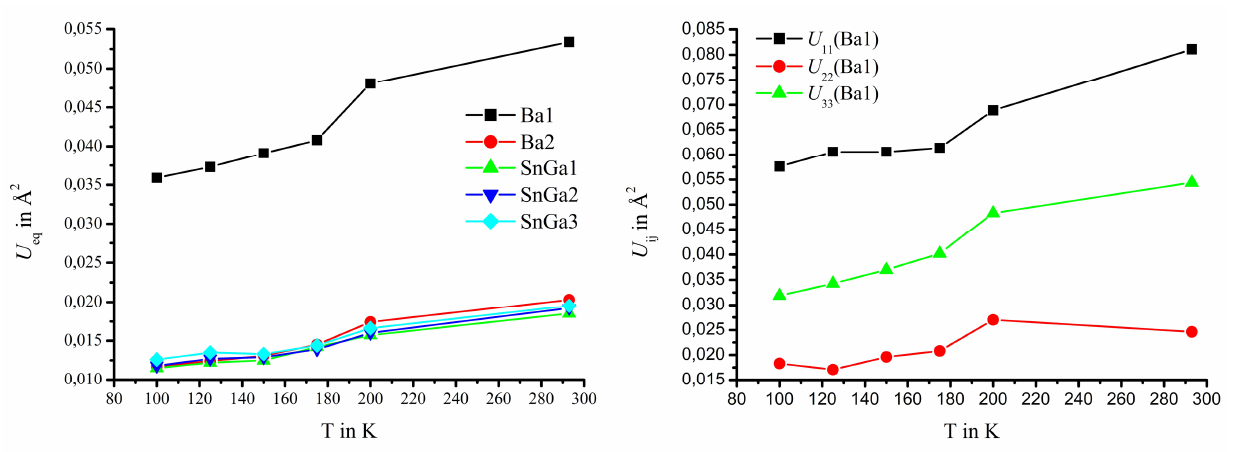
Figure 4. Temperature dependence of the isotropic ( a ) and anisotropic displacement parameters ( b ) for Ba